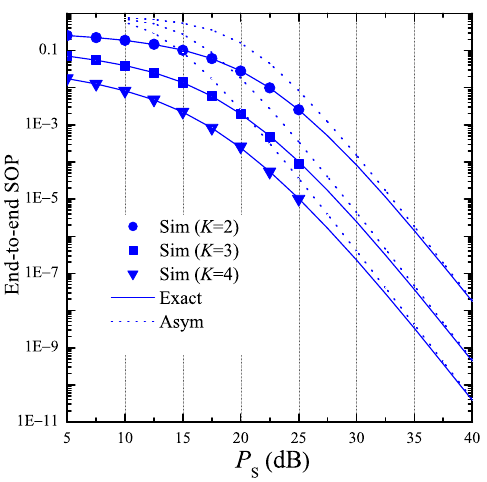
Figure 5. End-to-end secrecy outage probability as a function of P S when N D = 2, N E = 2, ε = 0.25, η = 0.25, C th = 0.2, x B = 0.5, y B = 0.3, x P = 0.5, y P = − 0.5, x E = 0.5, y E = 0.5, κ 2